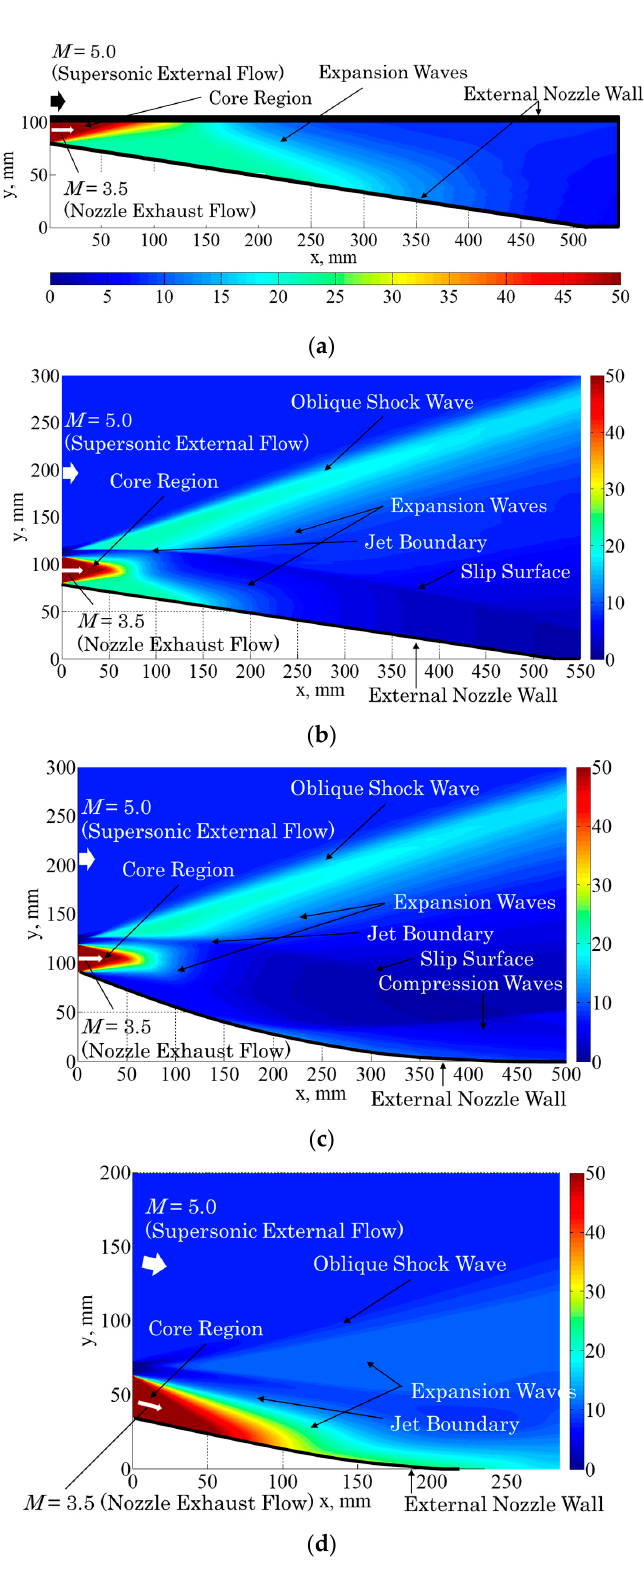
Figure 11. Pressure distributions of each external nozzle configuration showing the flowfield characteristics computed by CFD. The flow direction is from left to right. The location of x = 0 indicates the cell nozzle exit. The color bar represents the static pressure in the unit of kPa. The white region indicates the airframe. ( a ) Case 1; ( b ) Case 2; ( c ) Case 3; ( d ) Case 4.